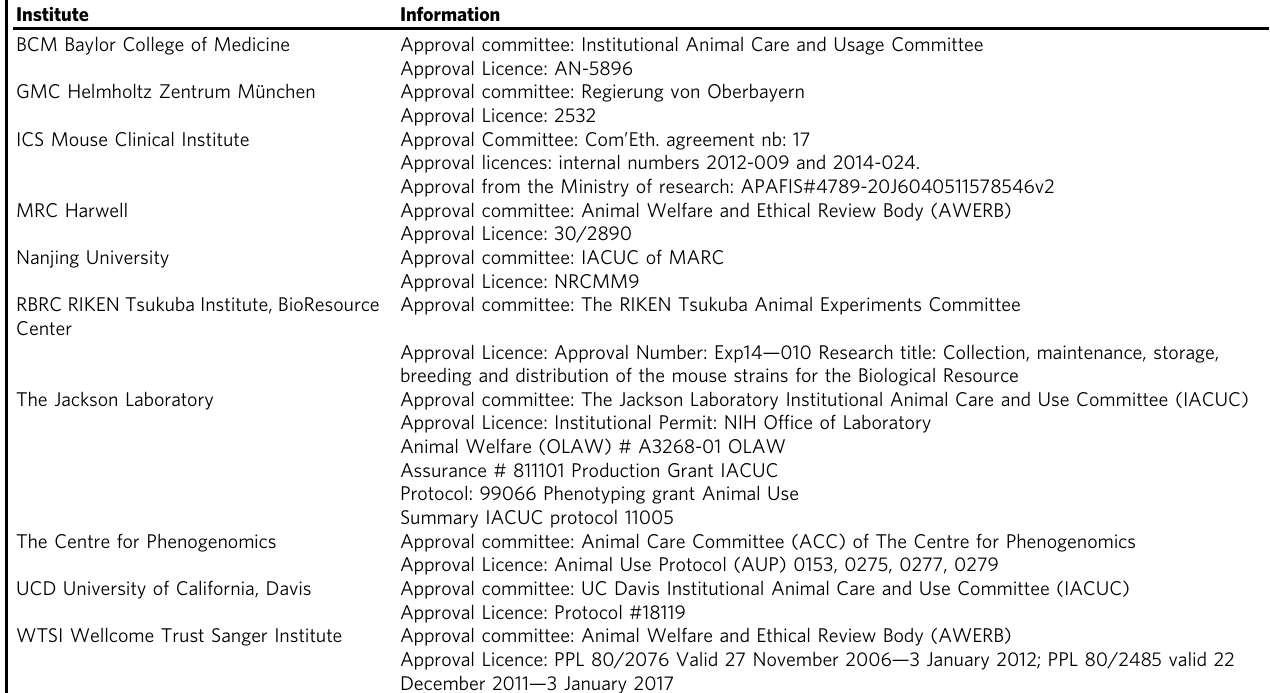
Table 2 Ethical review board information for each phenotyping